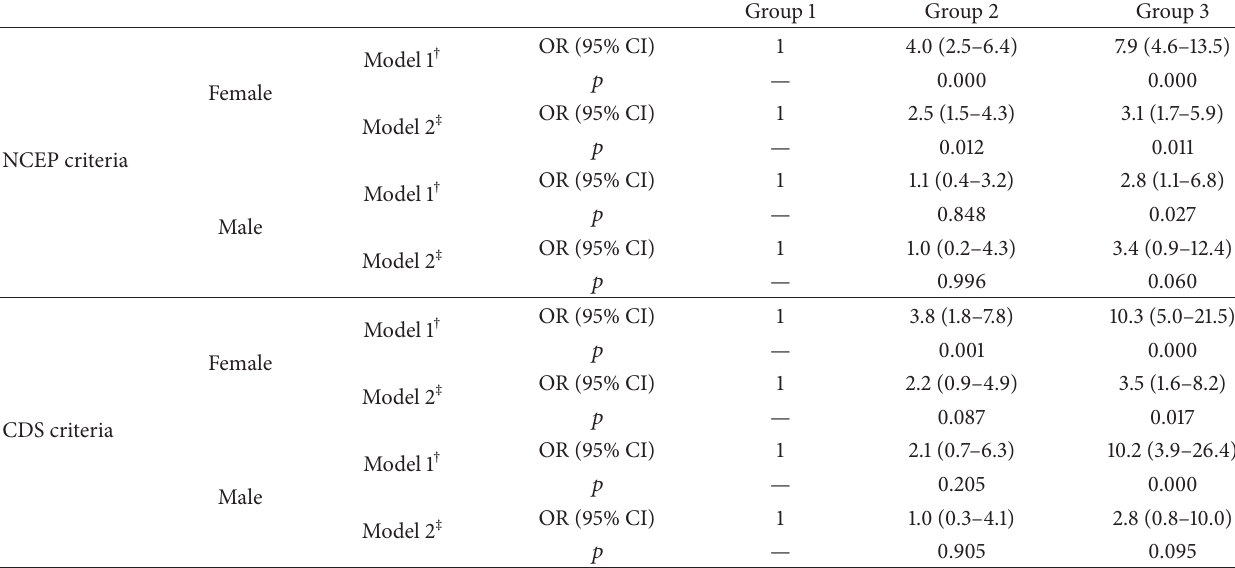
Table 3: Odds ratios (95% CI) and 𝑝 values for the metabolic syndrome by serum GGT and ferritin levels and by diagnostic